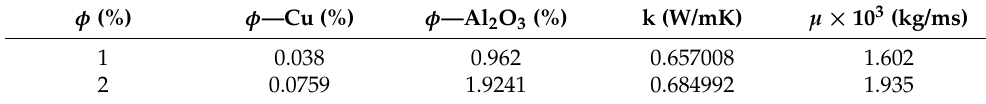
Table 2. Viscosity and thermal conductivity of NF at two different solid volume fractions of NPs [58]. φ (%) φ —Cu (%) φ —Al 2 O 3 (%) k (W/mK) µ × 10 3 (kg/ms) 1 0.038 0.962 0.657008 1.602 2 0.0759 1.9241 0.684992